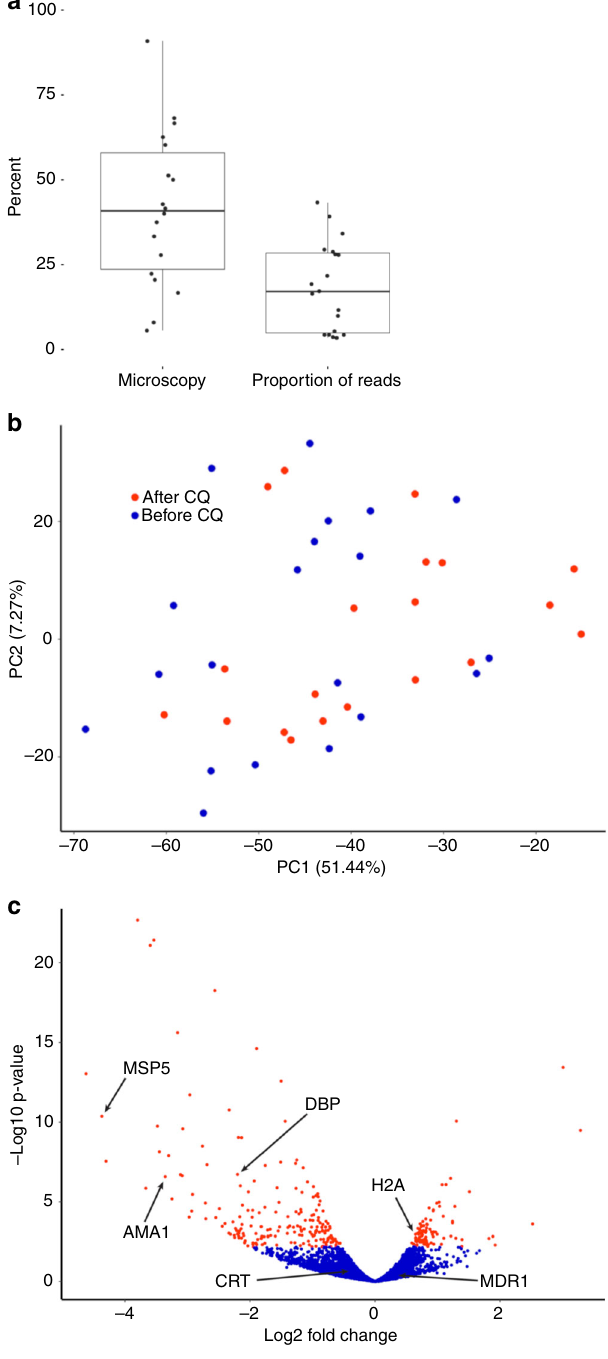
Fig. 3 Effect of chloroquine on parasite gene expression. a Decrease in the number of parasites 8 h after chloroquine administration (represented by the proportion of remaining parasites, in %) measured by microscopy and by the proportion of parasite reads. Each dot represents one infection, the centerline shows the median, the box limits the quartiles, and the whiskers indicate the range (with outliers removed). b Principal component analysis of the parasite gene expression pro fi les from each sample before (blue dots) and 8 h after chloroquine administration (red dots). c Volcano plot of the gene expression changes after chloroquine treatment. Each dot represents one annotated P. vivax gene and is displayed according to the fold-change in expression ( x -axis, in log2) and statistical signi fi cance ( y -axis, in negative logarithm to the base 10 of the p -value). Red indicates signi fi cantly affected genes (FDR <